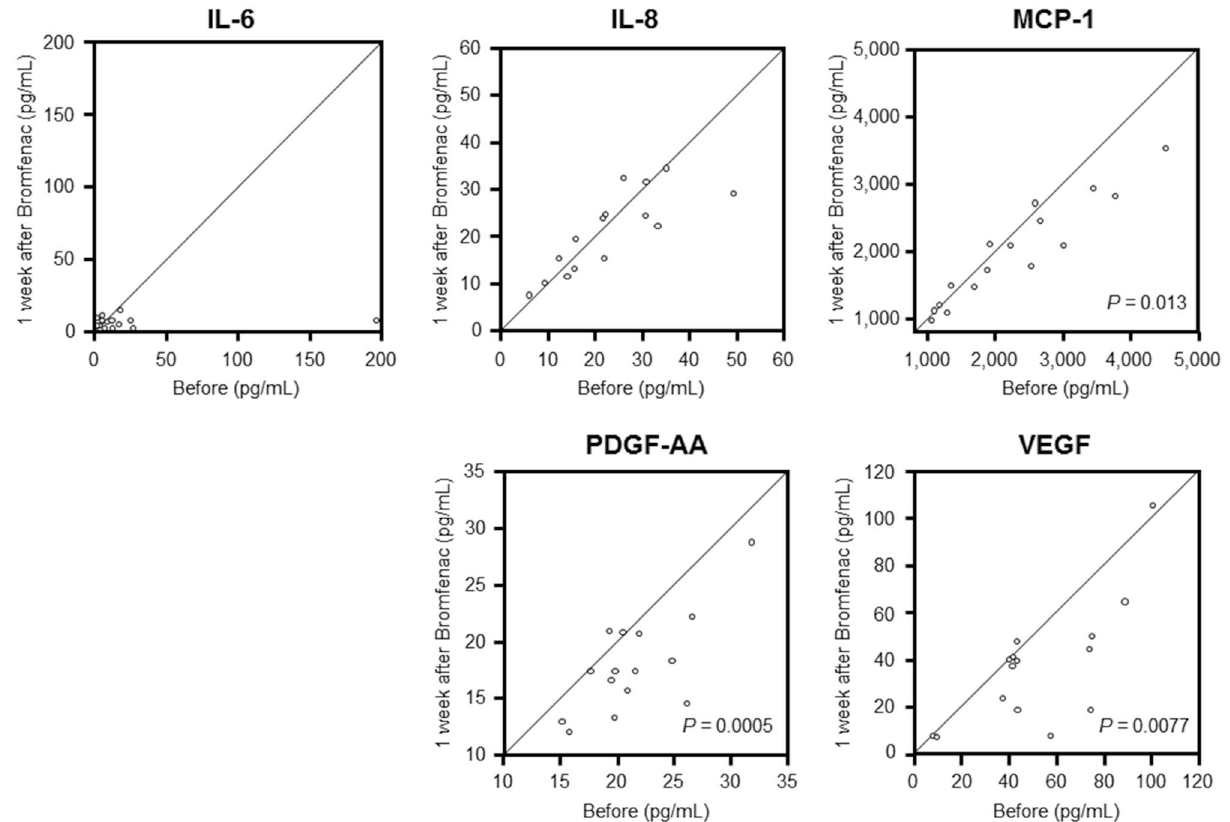
Figure 2. Scattergrams of inflammatory cytokine concentrations in the aqueous humour of patients with pseudophakic eyes before and after bromfenac administration. The x- and y-axes indicate the levels of each cytokine before and after treatment, respectively. The concentrations of MCP-1, PDGF-AA, and VEGF in the aqueous humour significantly decreased 1 week after bromfenac administration ( P = 0.013, P = 0.0005, and P = 0.0077, respectively, paired t test). There were no significant changes in the concentrations of IL-6 or IL-8 before and 1 week after bromfenac administration. IL interleukin, MCP-1 monocyte chemoattractant protein-1, PDGF-AA platelet-derived growth factor-AA, VEGF vascular endothelial growth